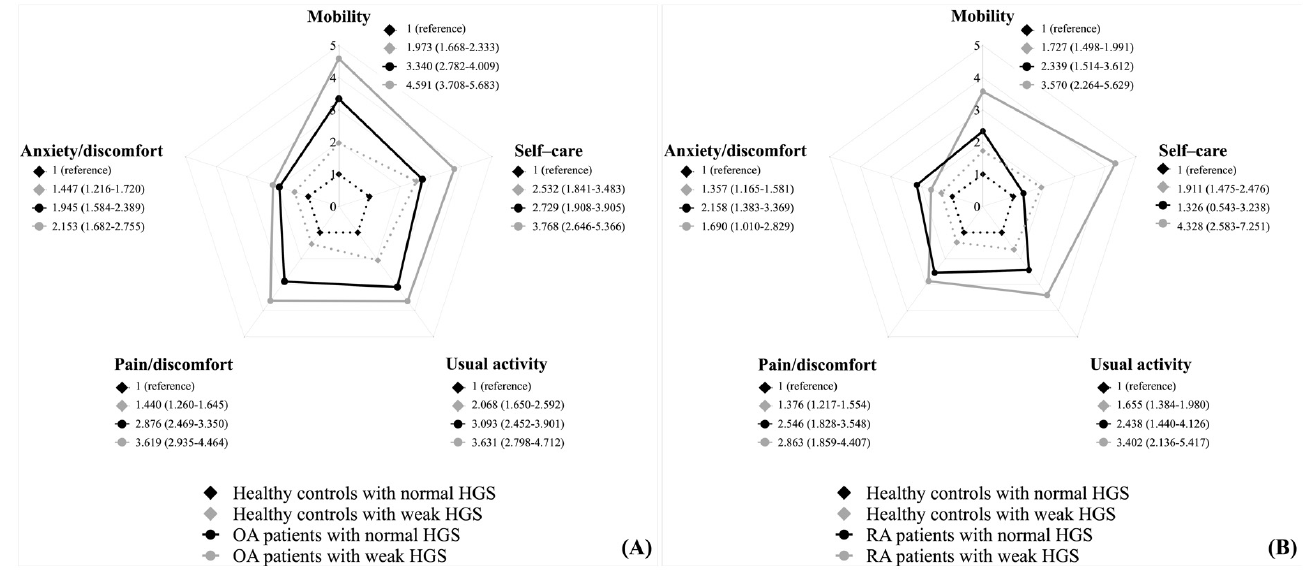
Figure 4. Associations between weak handgrip strength and impaired quality of life (the five dimensions of the EQ-5D) in patients with osteoarthritis ( A ) and patients with rheumatoid arthritis ( B